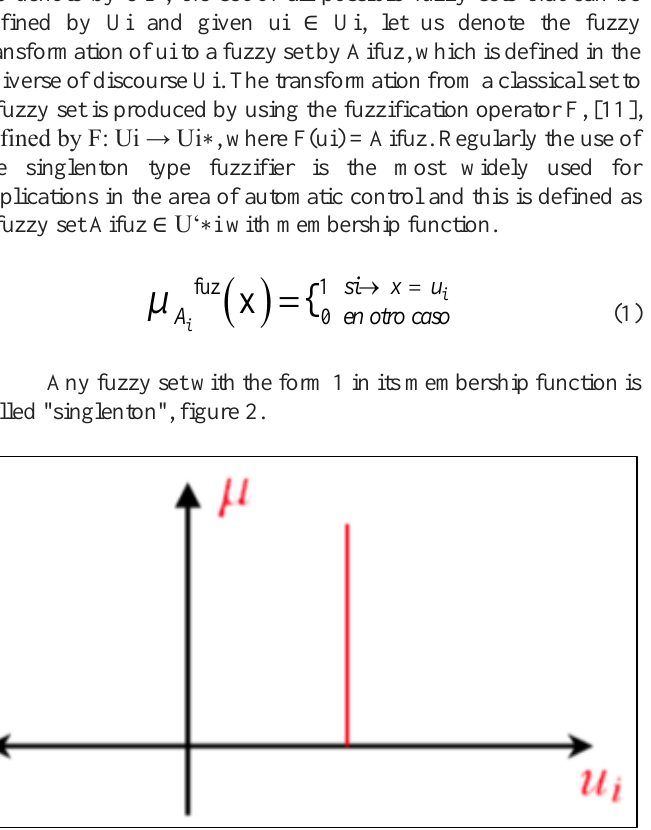
Figure 2: Singleton membership